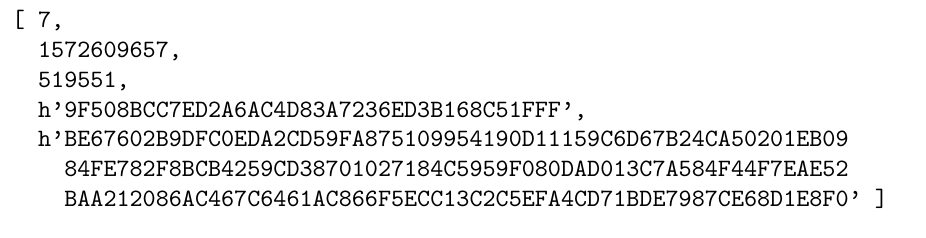
Figure 4. Example of an xAAL message ( Security Layer